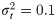
Performance of the identification under weaker PM signal (variance) σt2=0.1.p-value of the χ2 is plotted versus the amount of noise. Each curve represent a different number of sites from {10, 20 30} (a) 50 individuals (b) 100 individuals.